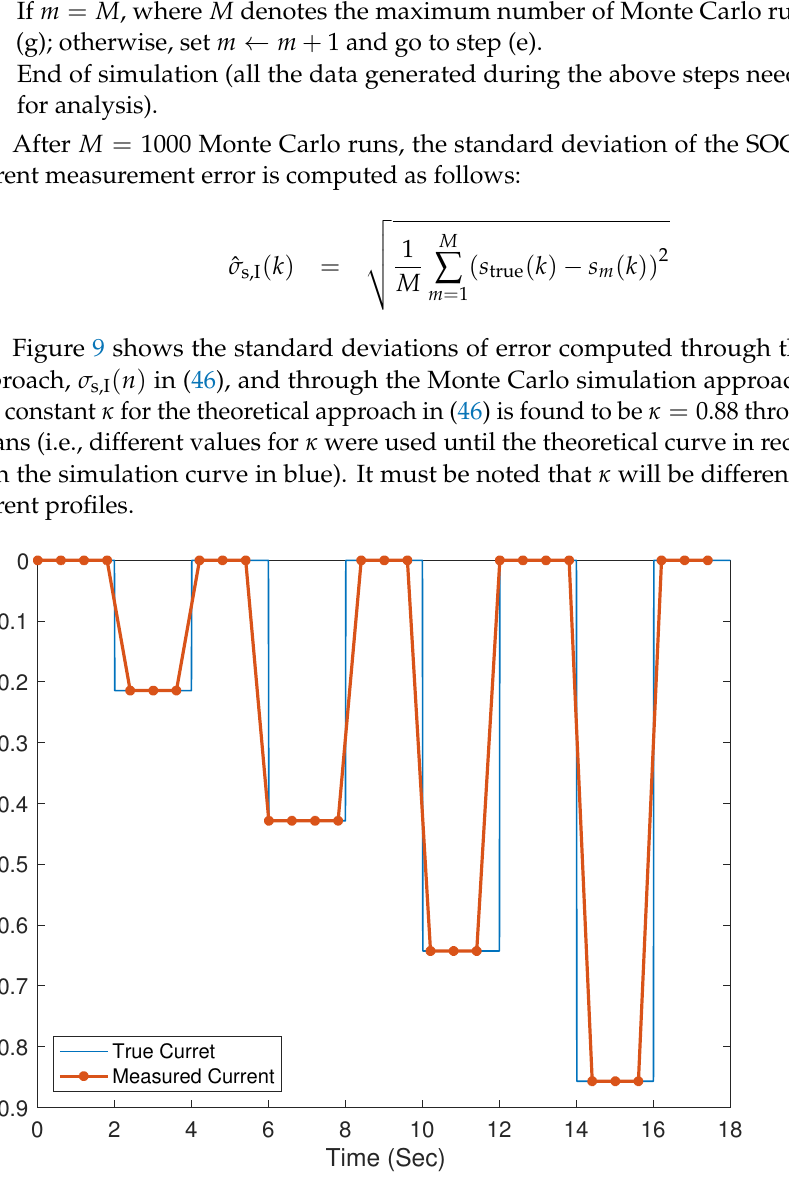
Figure 7. Perfectly integrable current profile. The blue curve shows a perfectly integrable current that is made of rectangular pulses of different amplitude; it can be integrated using the geometric approach detailed in Figure 3. The measured current, shown in red, is a downsampled version of the true current profile—this emulates the way in which discrete measurement systems measure the voltage/current in